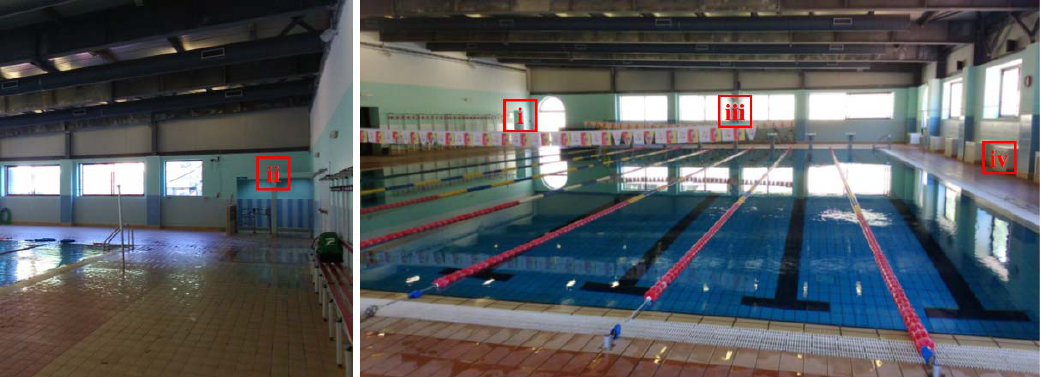
Figure 7. Locations of the air temperature and humidity sensors in the swimming pool hall: ( i ), edge of the swimming pool at a height of about 2 m; ( ii ) above the entrance of the dressing/bath zone; ( iii ) shorter wall of the swimming pool hall; ( iv ) one of the return air ventilation crates.